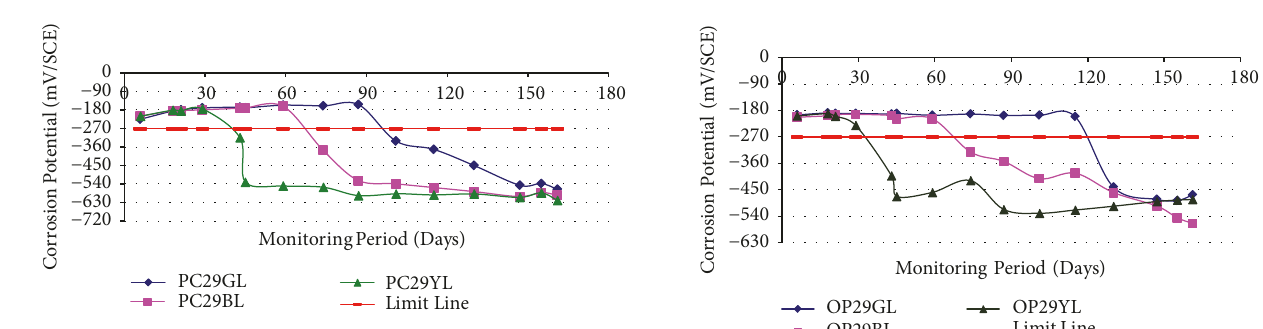
Figure 1: Corrosion potential versus time for PCDC at w/c of 0.85.